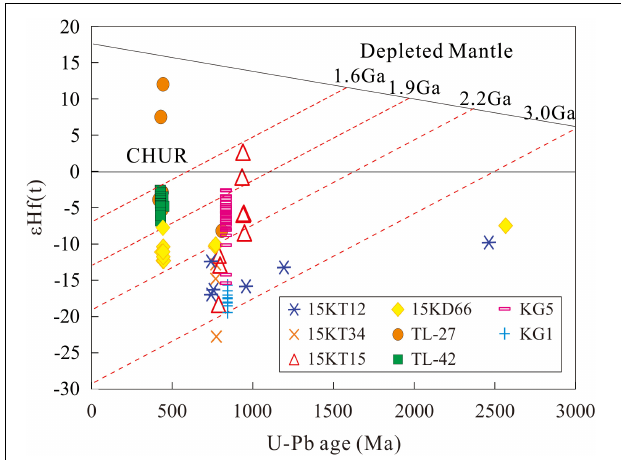
FIGURE 7 | ε Hf(t) vs. age plot showing most zircon samples from the Aktyuz Terrane with negative ε Hf(t) values. Samples: fuchsite schist (15KT12), granitic gneiss (15KT34), migmatitic amphibolite (15KT15), and gray granitoid gneiss (KG1, Kröner et al., 2012) of the Kemin Complex, well-banded leucogneiss (KG5, Kröner et al., 2012) of the Aktyuz Complex, and monzogranite porphyry (15KD66), diorite (TL-27, Zhao et al., 2017), and monzonite (TL-42, Zhao et al., 2017) outcropped in the Taldybulak Levoberezhny deposit.